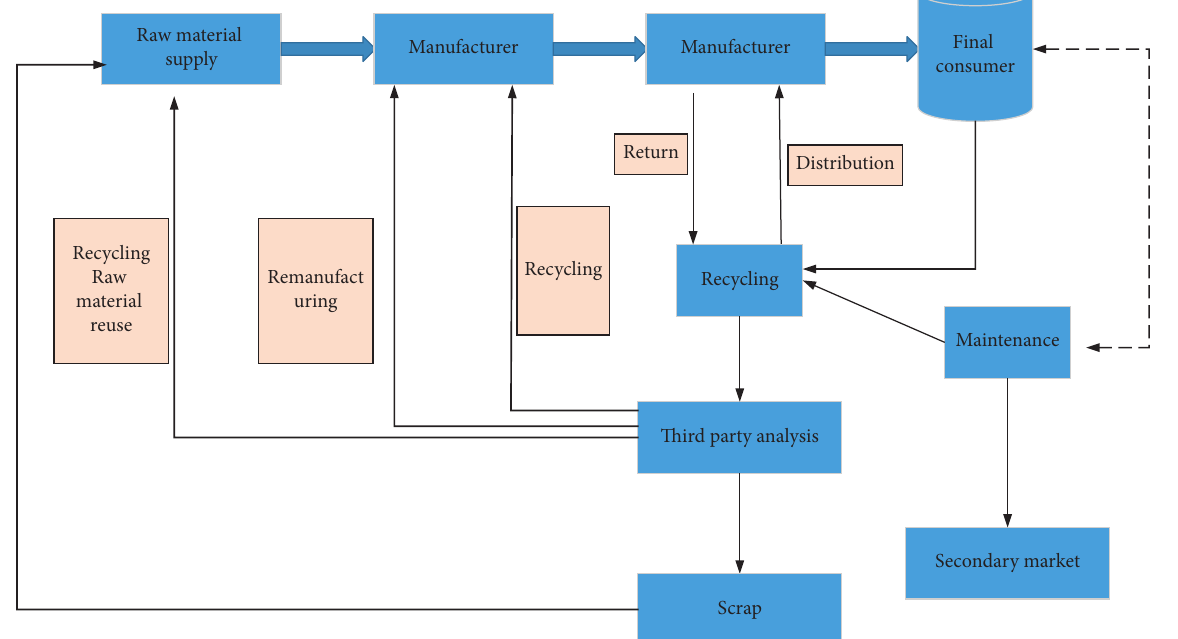
Figure 1: Basic structure of closed-loop supply